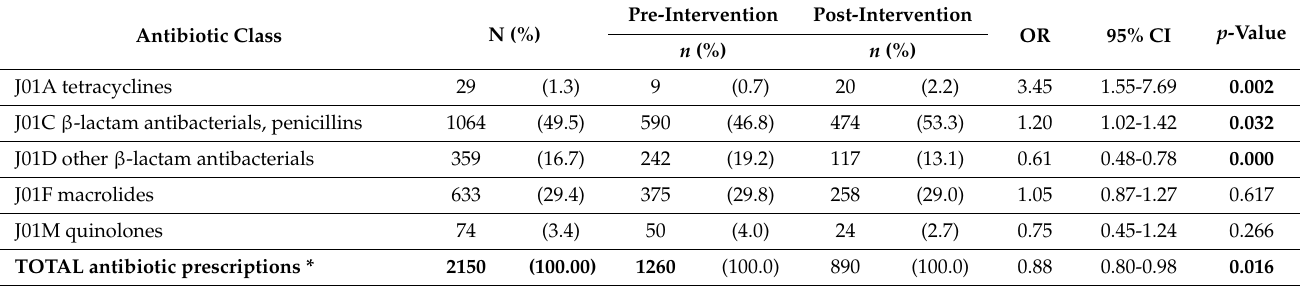
Table 6. Antibiotic prescribing by antibiotic class, pre- and